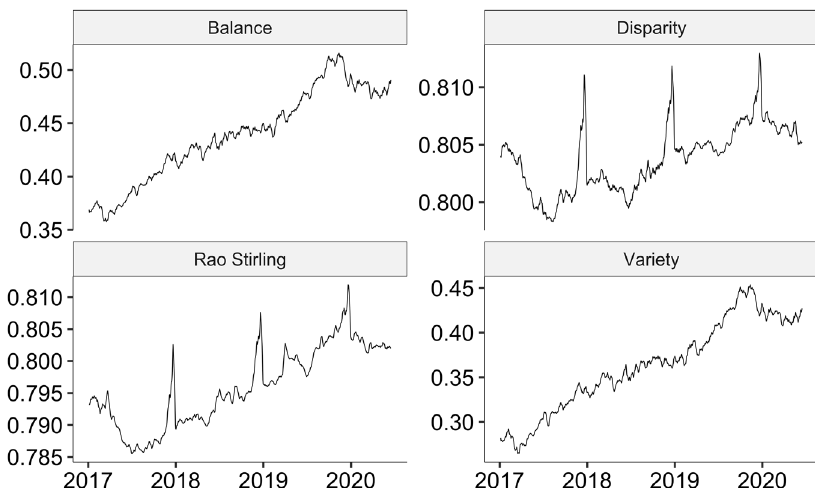
Fig. 4 Diversity of songs on the Spotify charts. Diversity, measured as balance, disparity, variety, or a combination of them, has been increasing consistently across countries with a plateau at the beginning of the year 2020. Besides the secular growth, disparity shows a strong seasonal component centered around Christmas.